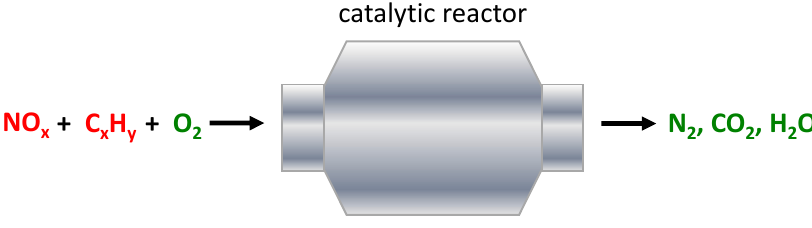
Figure 6. Schematic illustration of the catalytic HC SCR deNO x process.